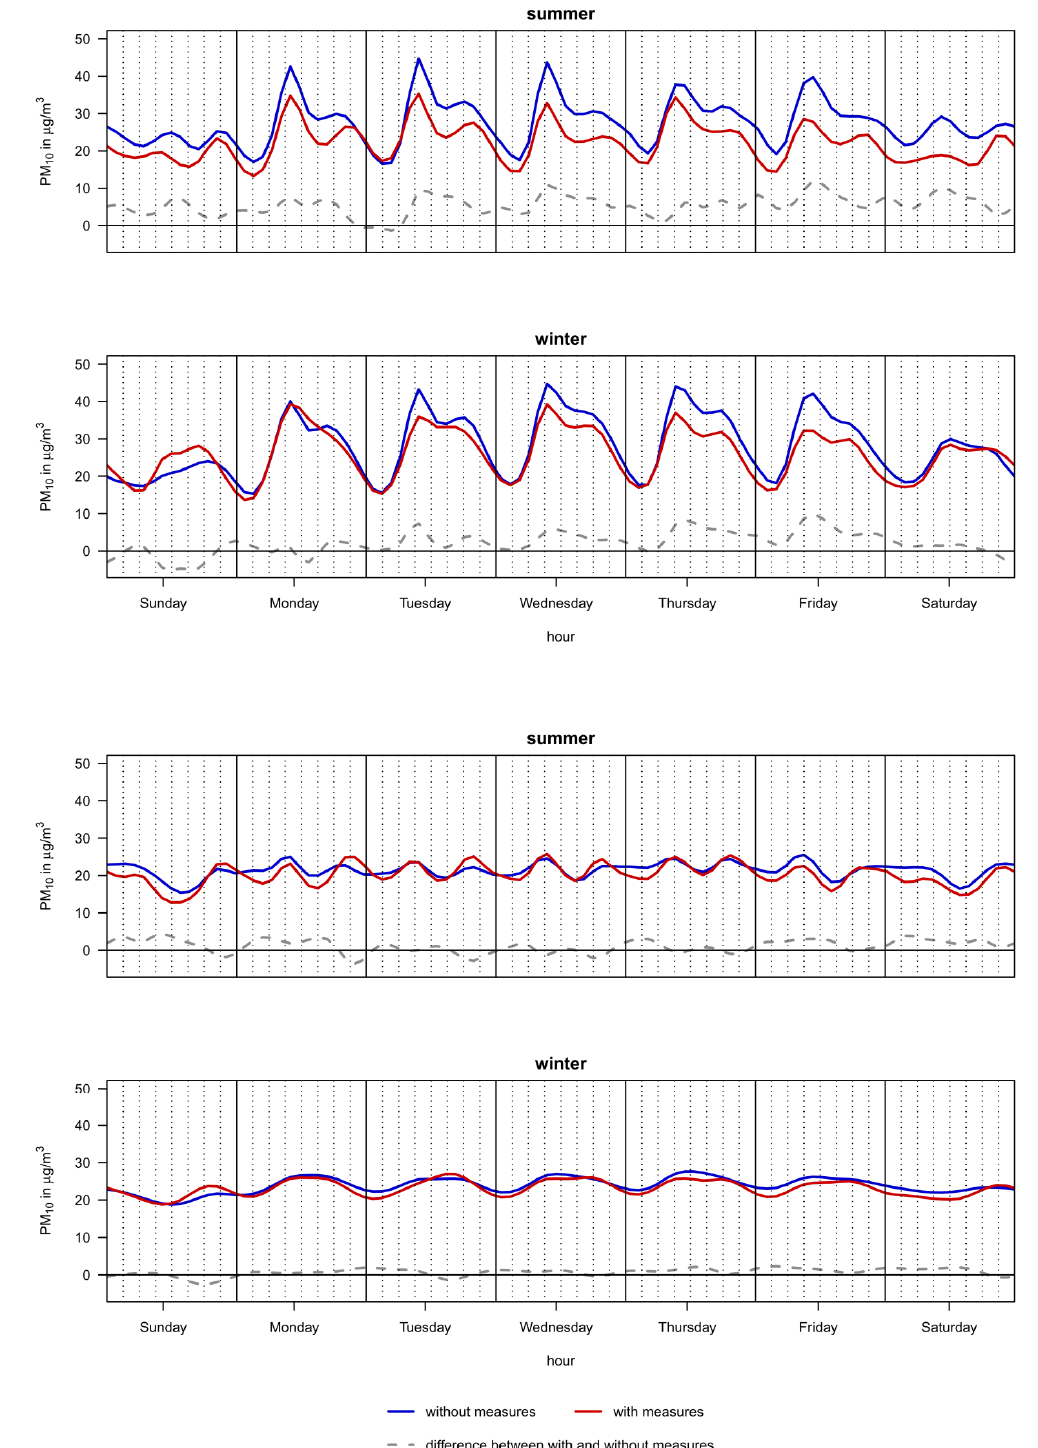
Figure 3. Modeled hourly concentrations of PM chart) and Lothstrasse (third, fourth chart) adjusted for PM direction and public